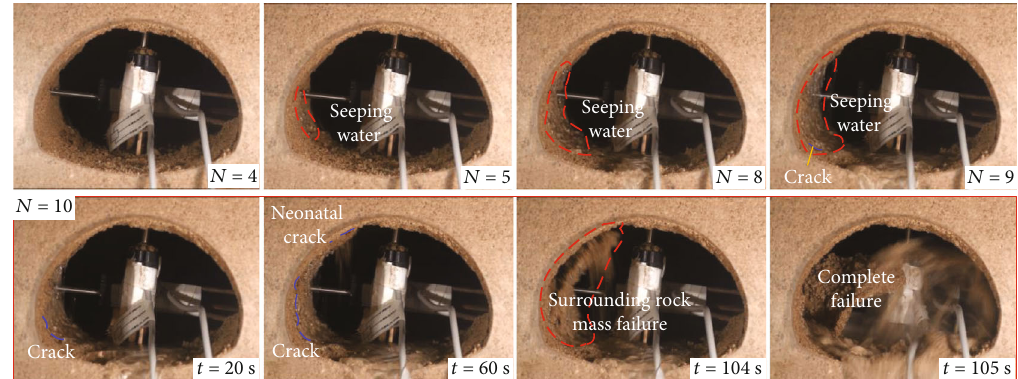
Figure 6: Seepage and failure process of tunnel ( d = 40 mm ).